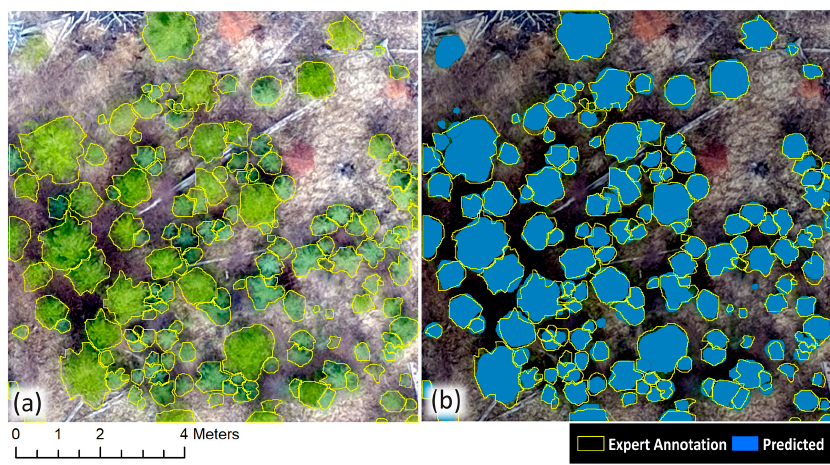
Figure 6. External Validation Tile d (B29). Annotated ground truth ITC are displayed yellow in both panels. The original image is displayed in ( a ). Predicted ITC are displayed in blue ( b ).